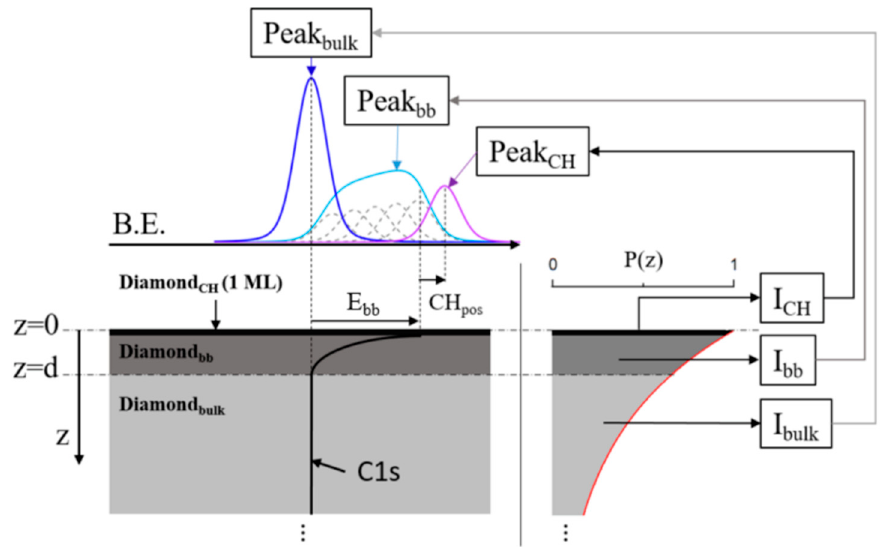
Figure 3. Schematic of the XPS model used for C 1s peak analysis. Sample is divided into three regions: diamond bulk (Diamond bulk ), diamond with band bending (Diamond bb ), and diamond surface C-H x (Diamond CH ) for the first monolayer of material. The intensities I bulk , I bb , and I CH of the respective XPS peaks Peak bulk , Peak bb , and Peak CH are obtained from their respective ratios. Peak bulk and Peak CH follow Voigt distributions; Peak bb is defined by its band bending width (d) and band bending (E bb ). The latter is set to the Peak bulk position. Adapted from the graphical abstract of Alba et al. [83].